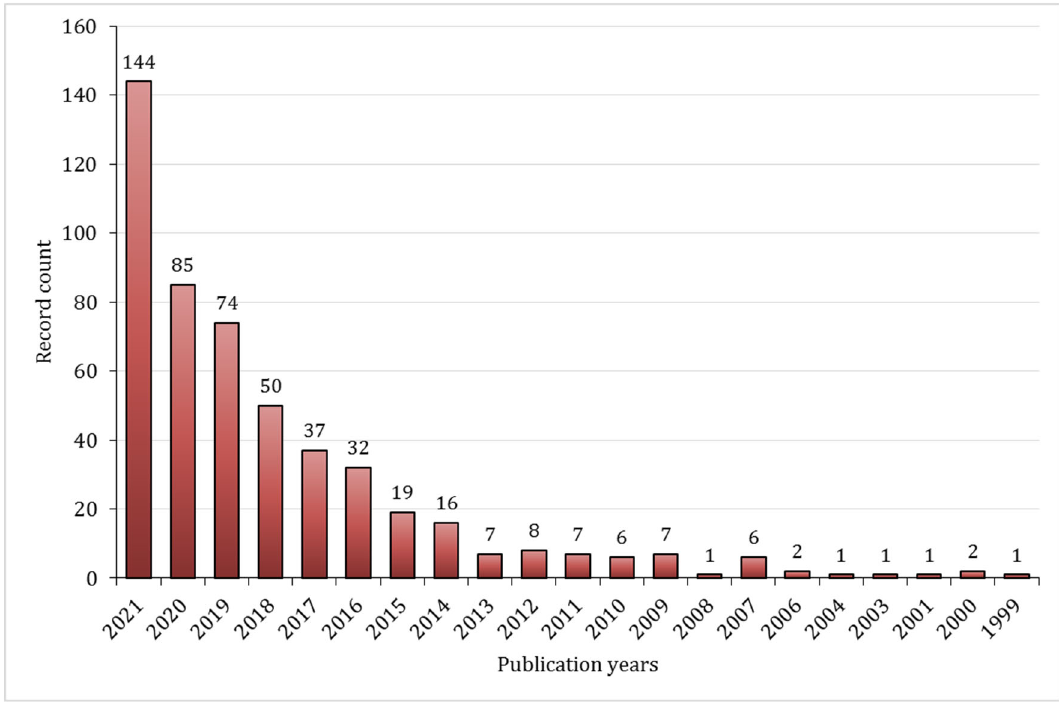
Figure 1. Number of published documents between 1999 and 2021, based on the data from Web of Knowledge, query “ Schiff ‐ base hydrogels ”. Data retrieved 30 September 2022.